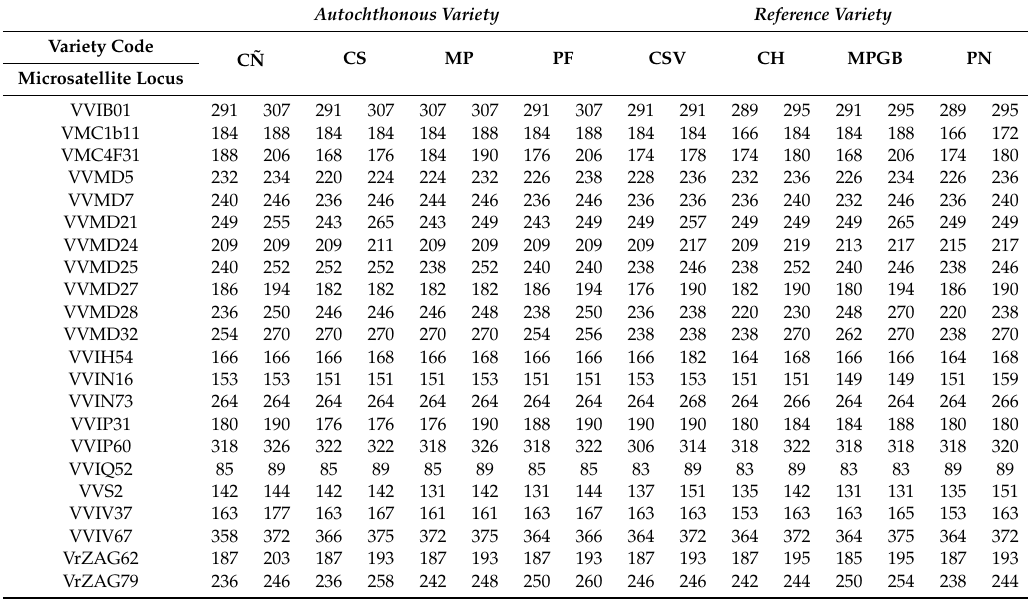
Table 1. Genetic profiles of the autochthonous and reference varieties at 22 microsatellite loci. Allele sizes are given in base